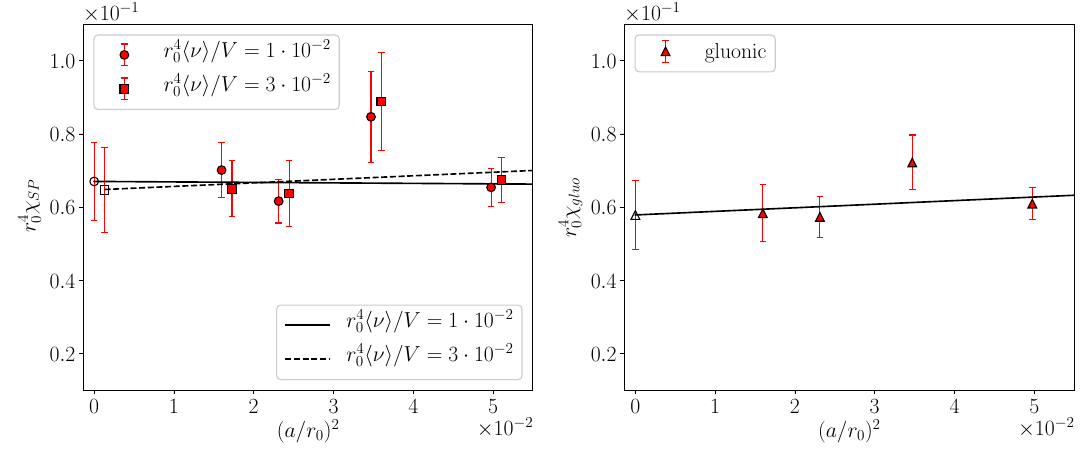
Figure 3 . Extrapolation towards the continuum of χ SP and χ gluo at T =